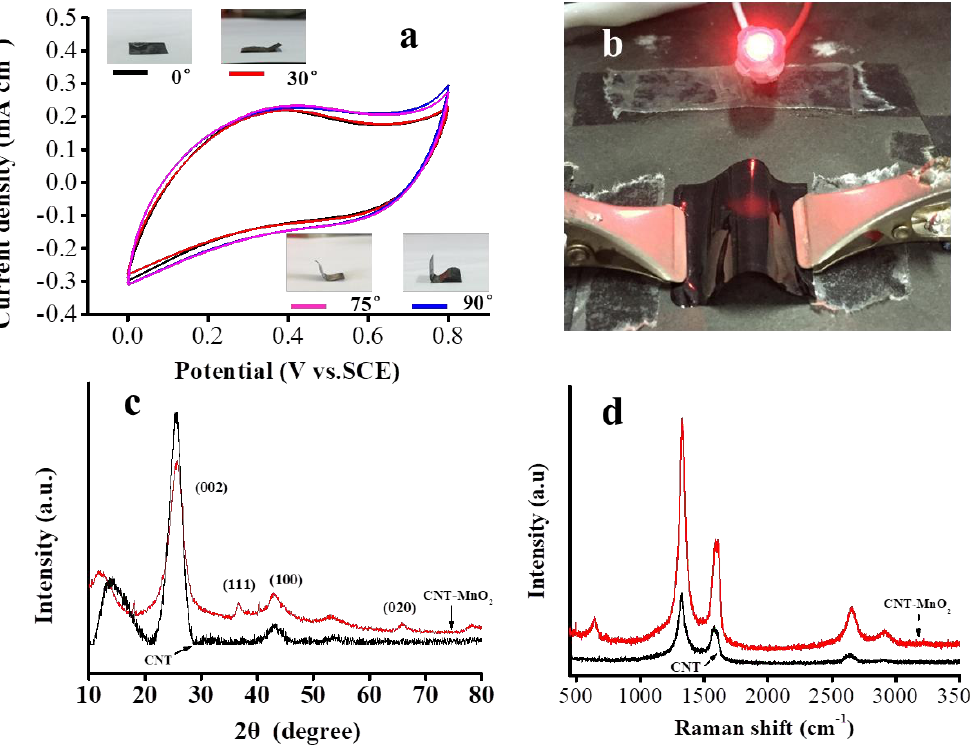
Figure 2. ( a ) CV curves of the composite at different bending angles at 5 mV s − 1 ; ( b ) photographic demonstration of the sample MCP40S60 as the flexible composite; ( c ) XRD patterns of CNT and MnO 2 /CNT; ( d ) Raman spectra of CNT and MnO 2 /CNT .